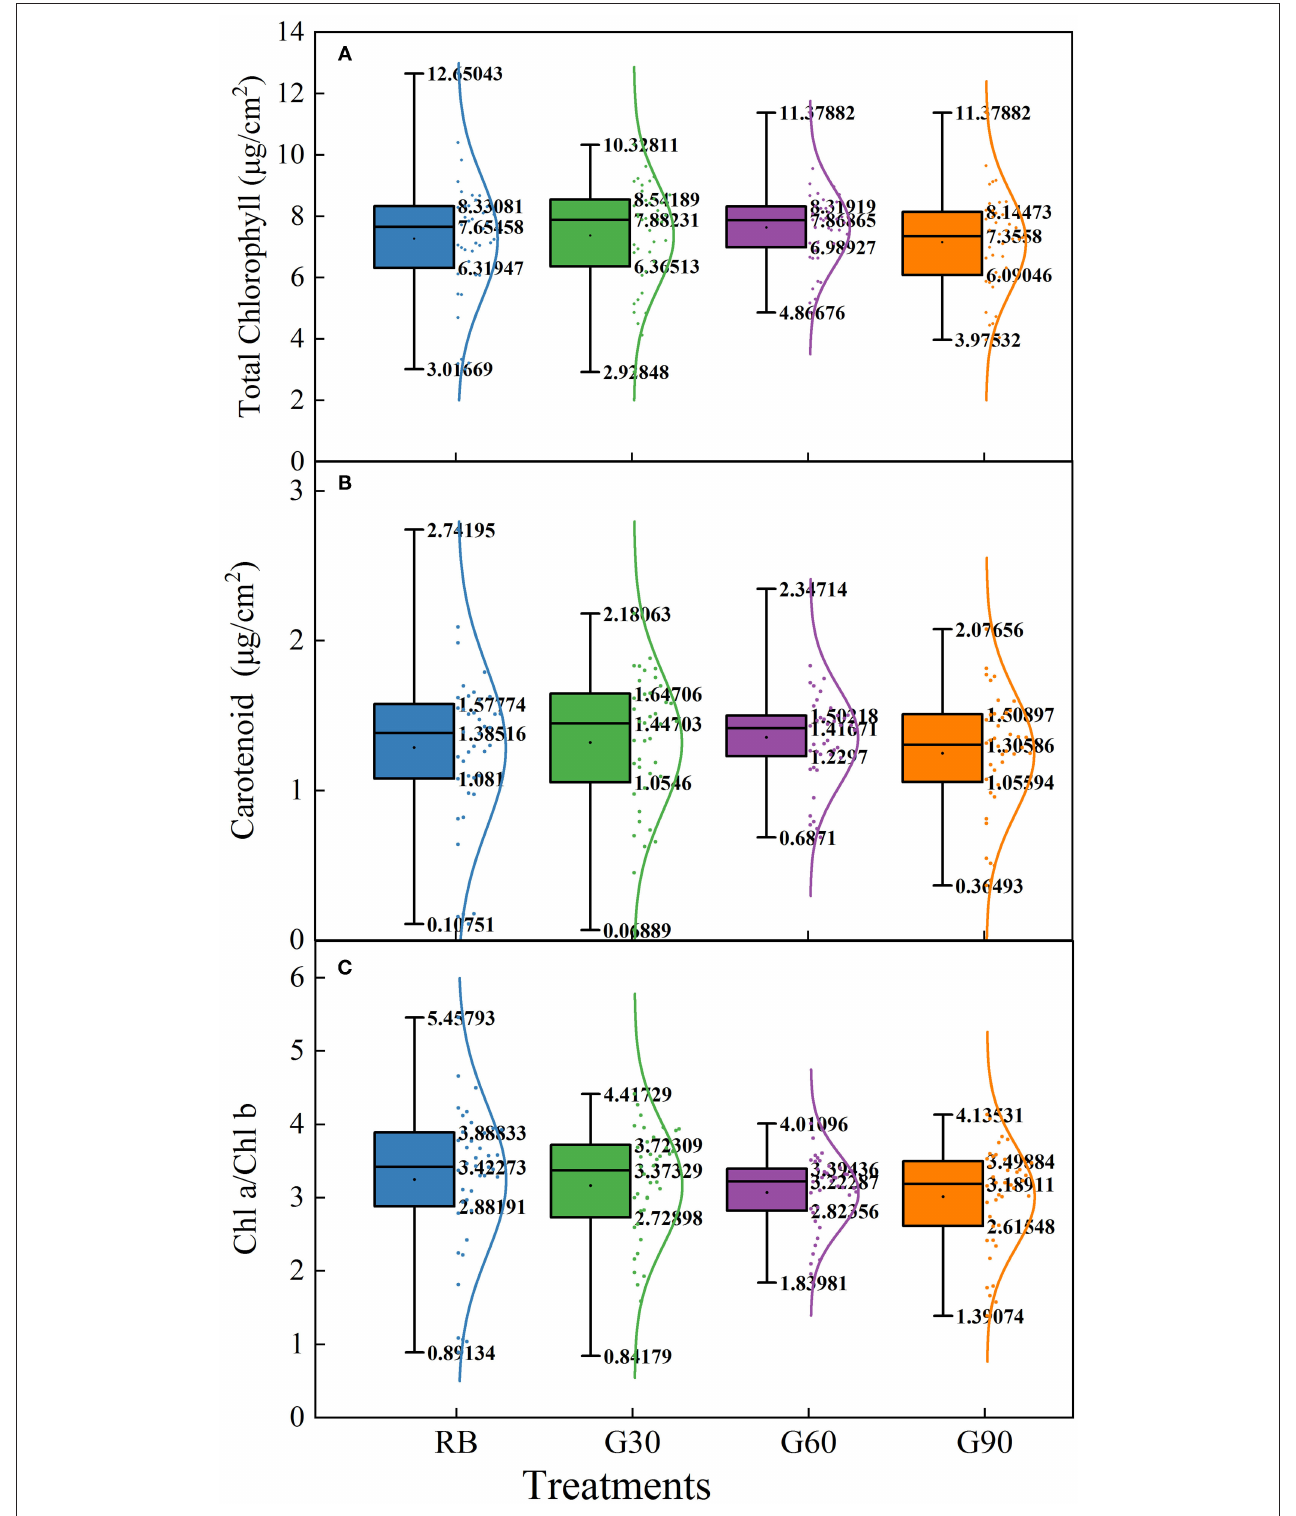
FIGURE 7 | Box-plot and normal distribution of concentrations of total chlorophyll (A) , carotenoid (B) , and Chl a/Chl b (C) of different layers of lettuce under different proportions of green light.